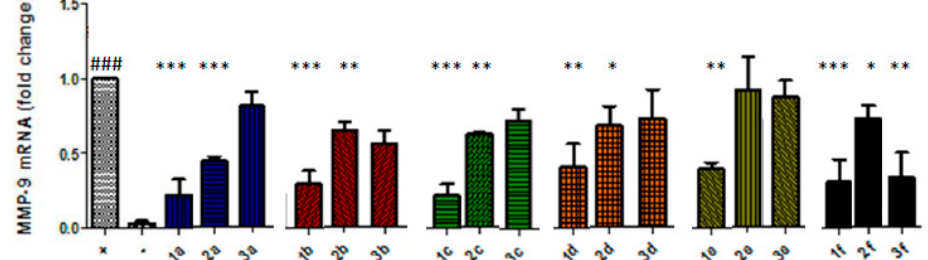
Figure 2. Barbiturate-nitrate hybrids (series 1) reduce MMP-9 mRNA to a greater extent than the barbiturate alcohols (series 2) or the nitrate side-chains (series 3). Caco-2 cells were incubated with series of the barbiturate-nitrate hybrids, barbiturate-alcohols or nitrate side-chains at 10 µM for 30 min prior to addition of TNF- α and IL-1 β (10 ng/mL). ### p < 0.001 vs unstimulated Caco-2 cells (negative control); * p < 0.05 vs cytokine-stimulated Caco-2 cells (positive control); ** p < 0.01 vs positive control; *** p < 0.001 vs positive control.